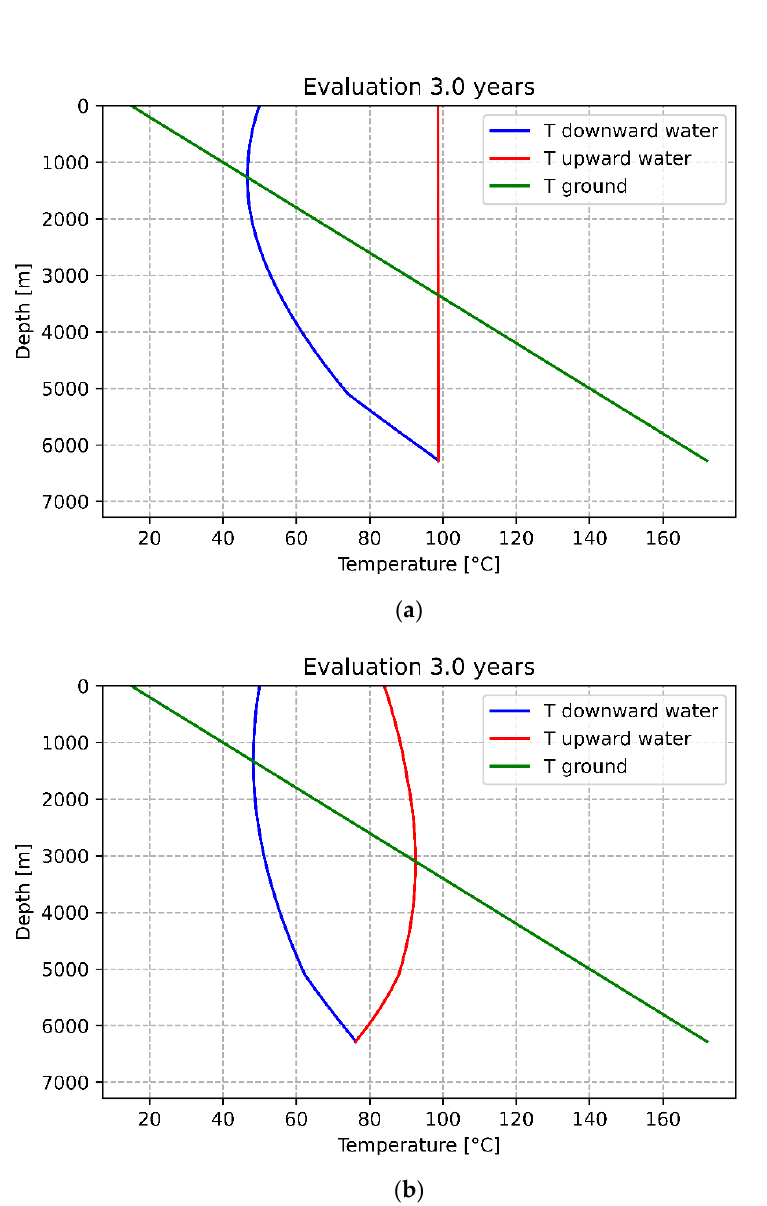
Figure 7. Temperature profile associated with the coaxial WBHE ( a ) and U-tube WBHE ( b ) configurations considering site-specific stratigraphy.